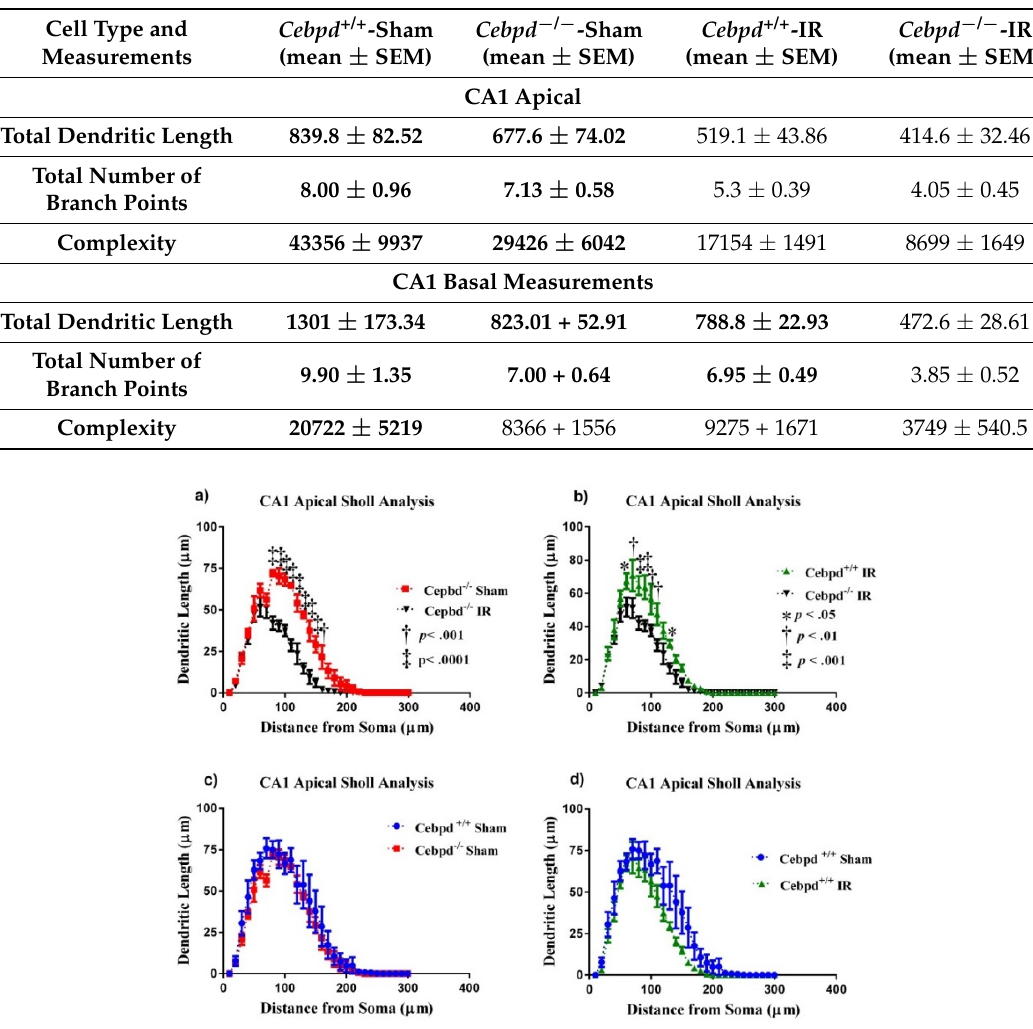
Figure 4. Sholl analyses of neurons in the CA1 apical. ( A ) Dendritic length, measured by Sholl analysis radiation decreased length at 80–160 µ m from the soma when Cebpd − / − -sham were compared to Cebpd − / − -IR. ( B ) Treatment greatly decreased length at 80–160 µ m from the soma when Cebpd +/+ -IR were compared to Cebpd − / − -IR. There were no significant differences observed when ( C ) Cebpd +/+ -sham were compared to Cebpd − / − -sham or ( D ) Cebpd +/+ -sham were compared to Cebpd +/+ -IR. Average ± SEM ( n = 5) * p < 0.05, † p < 0.01. ‡ p <